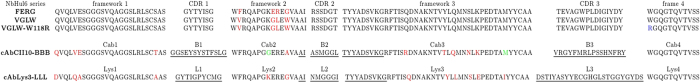
Representative sequences corresponding to the VHHs analyzed in this work.The first three illustrate the NbHul6 series. FERG-VGLW mutations are highlighted in red, while the W111R substitution is in blue. The last two are the wt sequences corresponding to the VHHs used for swapping. The fragments swapped between frameworks are underlined. In green are reported the discrepancies between literature and the PDB data.